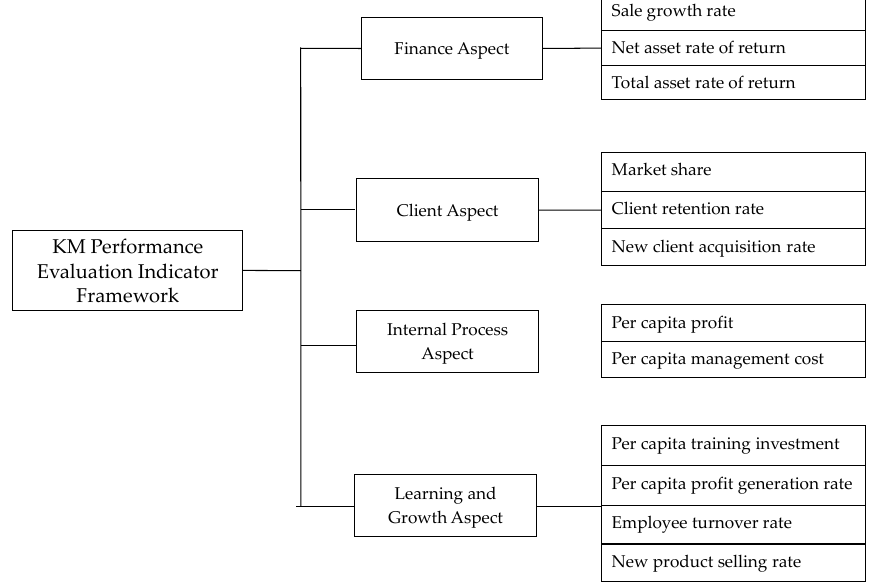
Figure 3. The framework of KM performance evaluation indicators.